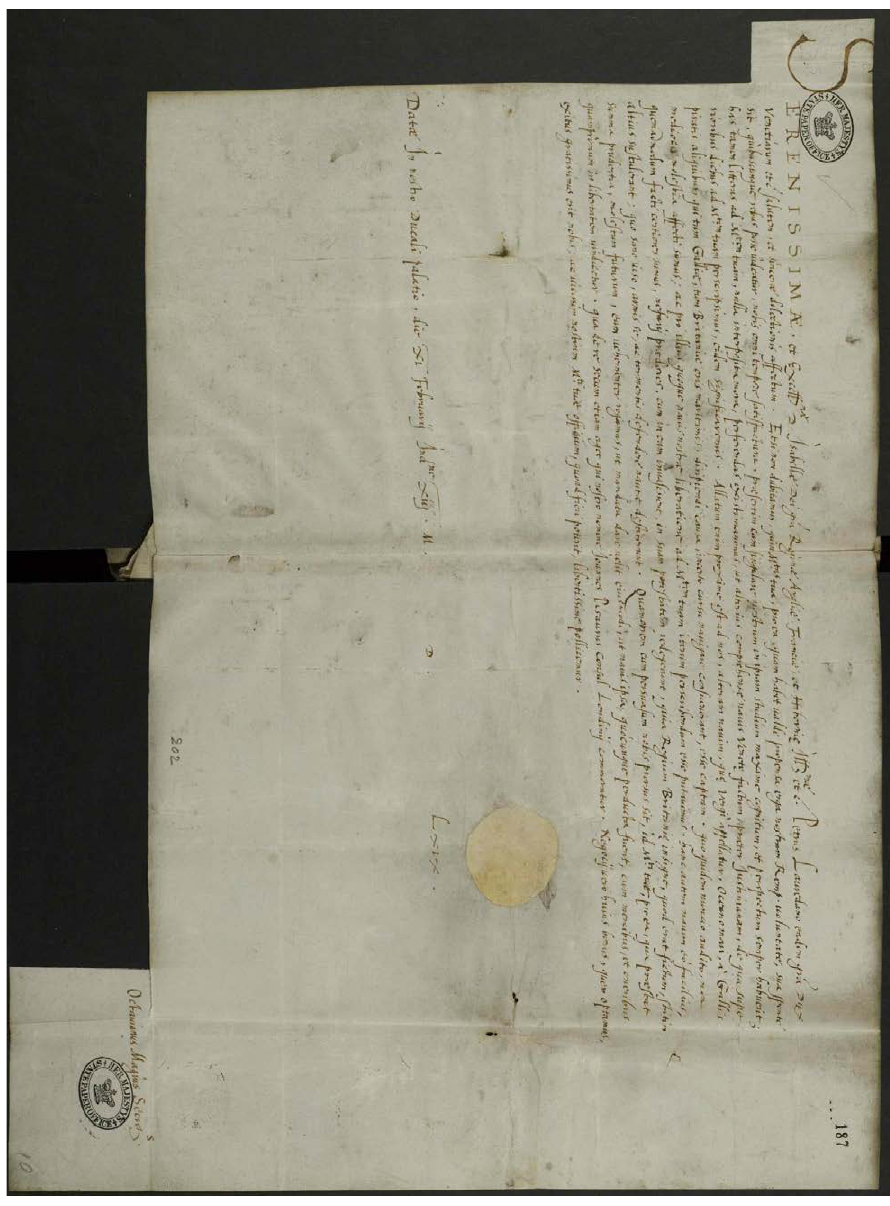
Fig. 6a – A formal Venetian lettera ducale, 1569 (reproduced by permission of the National Archives,